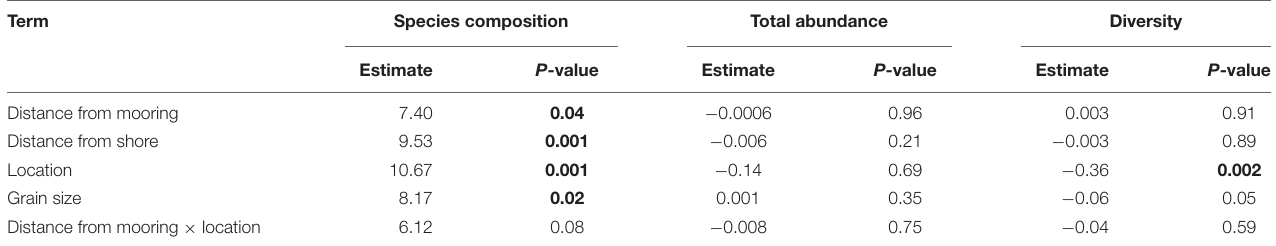
TABLE 1 | Results from generalized linear models used to test for effects of distance to moorings, distance from shore, location and grain size on the multivariate composition of infaunal species, and the univariate total abundance per sample and diversity (Shannons Diversity H’). Term Species composition